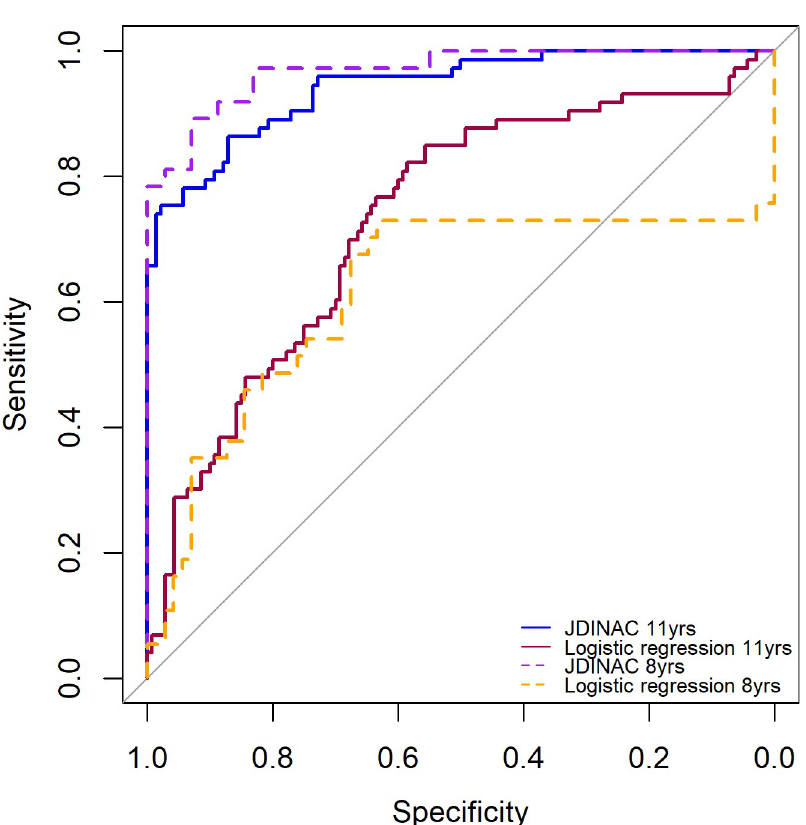
Fig 5. ROC curves for JDINAC and penalised logistic regression. The curves were obtained through the prediction averaging procedure on 50 independent repetitions combined with of 10-fold cross validation. JDINAC, joint density- based nonparametric differential interaction network analysis and classification; ROC, receiver operating